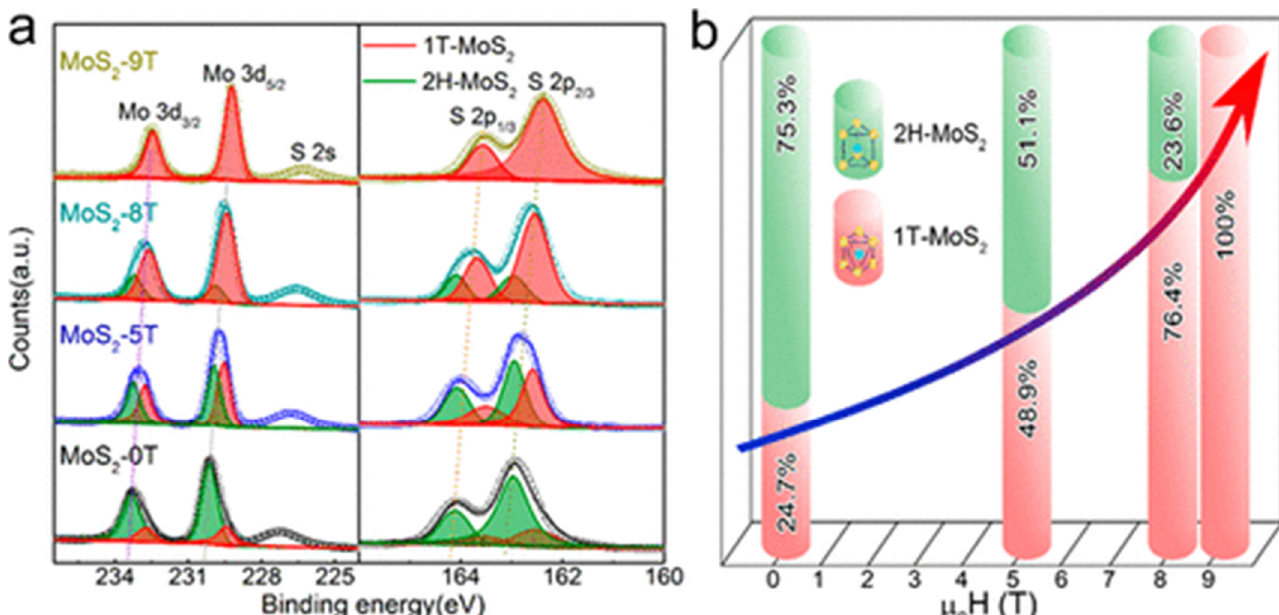
Figure 7. ( a ) XPS results of the as-synthesized MoS 2 processed under different magnetic fields in magneto-hydrothermal processing. ( b ) Phase percentage of MoS 2 from deconvolution of XPS spectra. Reproduced with permission of ref. [159]. Copyright 2019. American Chemical Society.